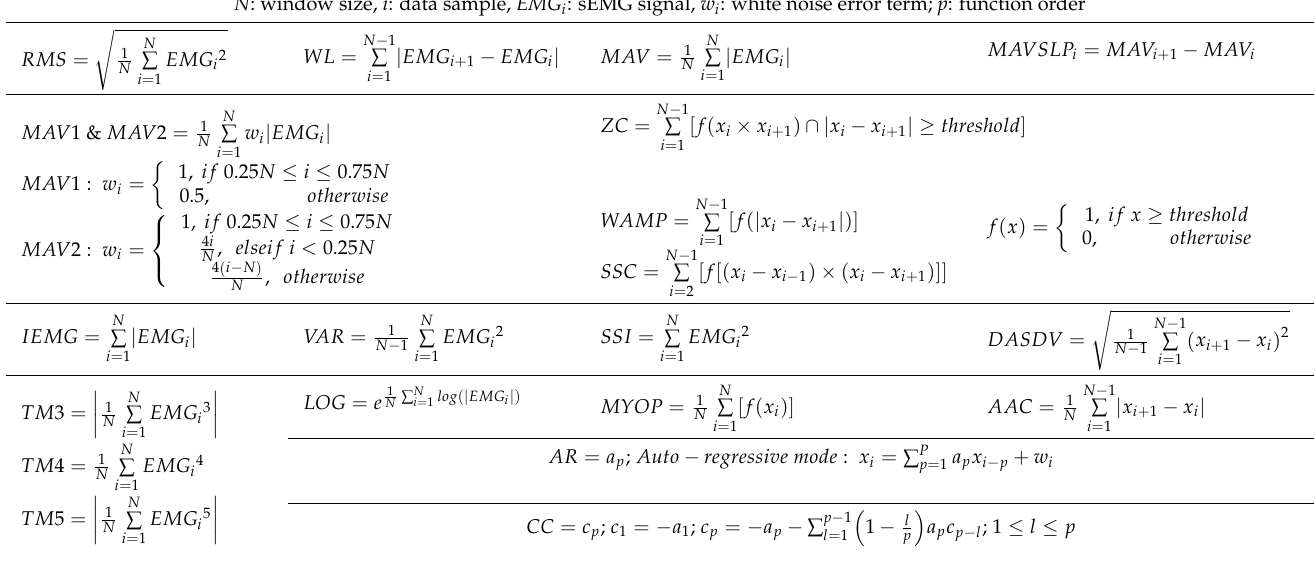
Table 2. Time-domain feature